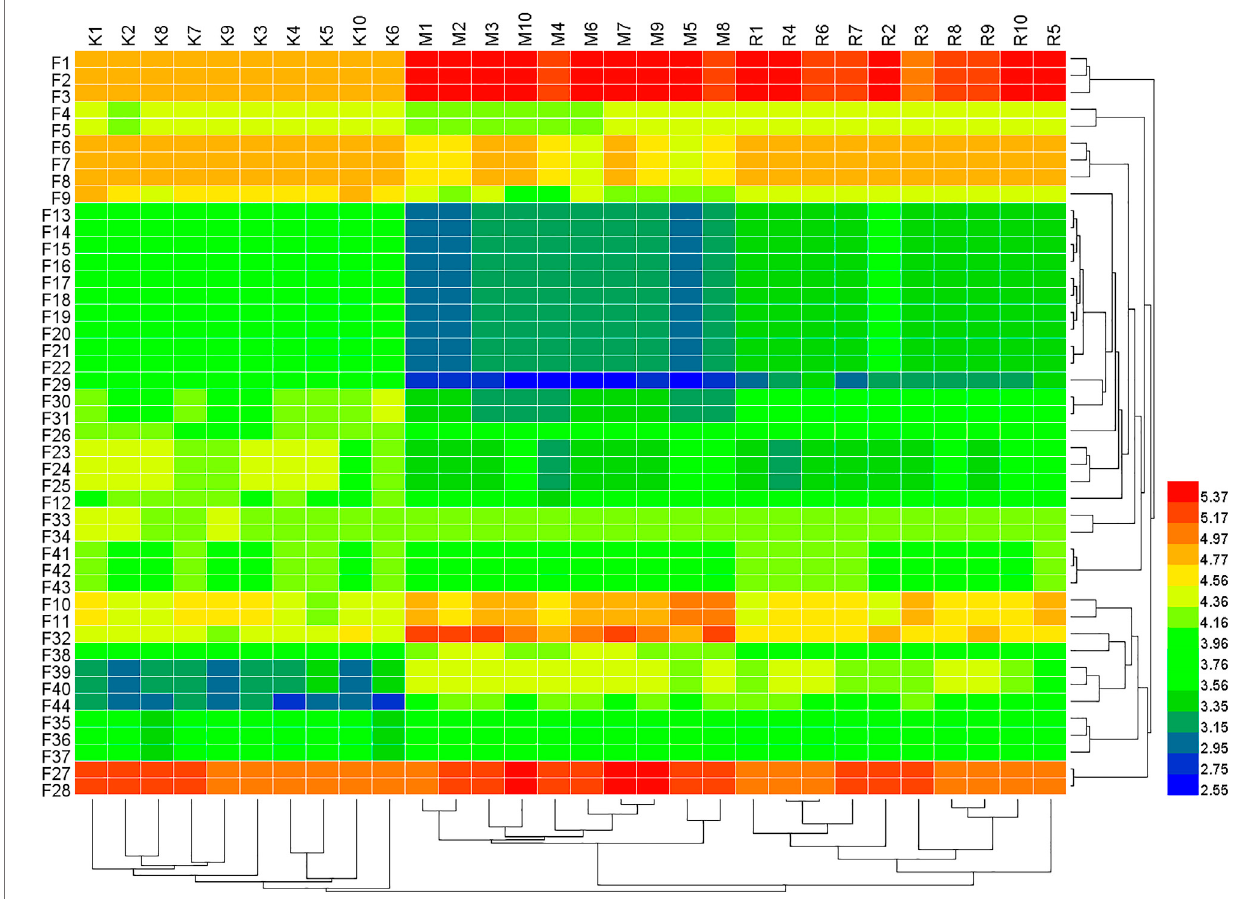
FIGURE 4 | Heat map of the differences in the potential biomarkers of the Control, Model and R. Scrophulariae groups obtained in the positive- and negative-ion modes. F represents feces. K represents control group, M represents model group, R represents R. Scrophulariae group.